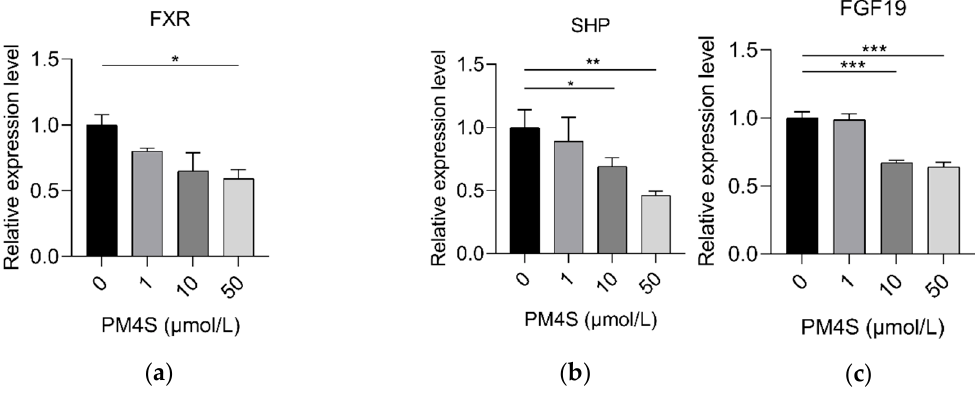
Figure 7. Relative expression of ( a ) FXR , ( b ) SHP , and ( c ) FGF19 in pig primary hepatocytes with an increasing dose of PM4S, respectively. n = 3/group. Data are shown as means ± SE, * p < 0.05, ** p < 0.01, *** p < 0.001.